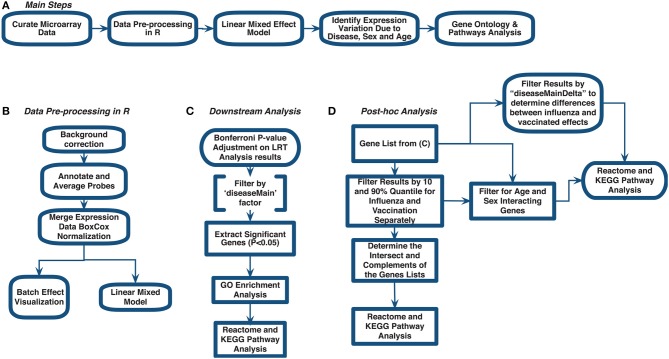
Meta-analysis workflow to assess gene expression variation in influenza disease and vaccination. (A) Main steps. (B) Data pre-processing in R. (C) Downstream analysis. (D)
post-hoc analysis.